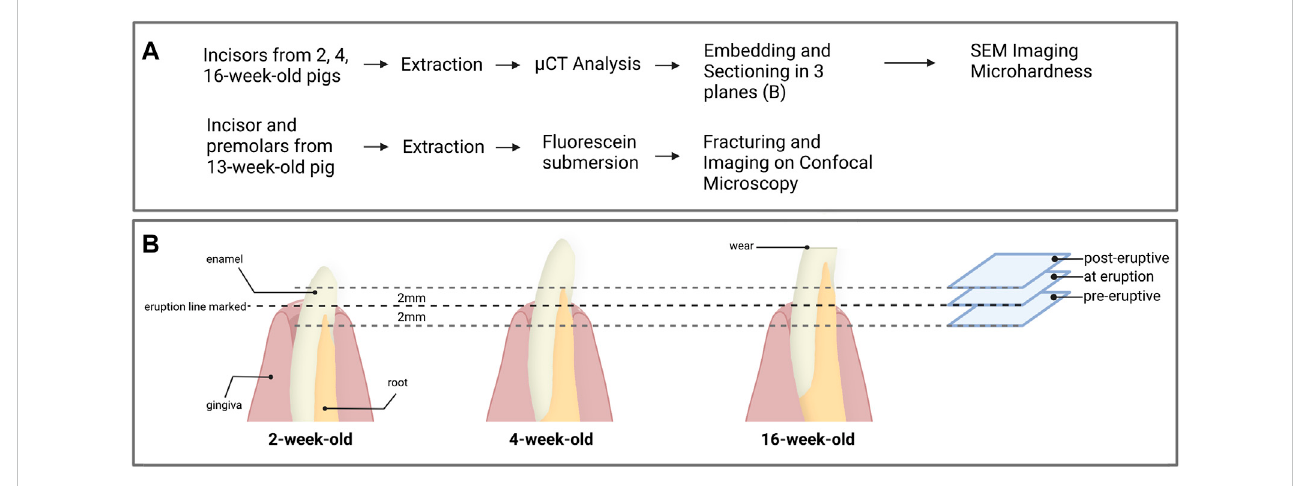
FIGURE 2 (A) Overview of the experimental work fl ow and (B) processing of the fi rst incisors for each age groups. Prior to extraction, the eruption line was marked on the incisors from 2, 4 and 16-week-old pigs. After extraction and microCT analysis, the samples were embedded and three transverse sections were